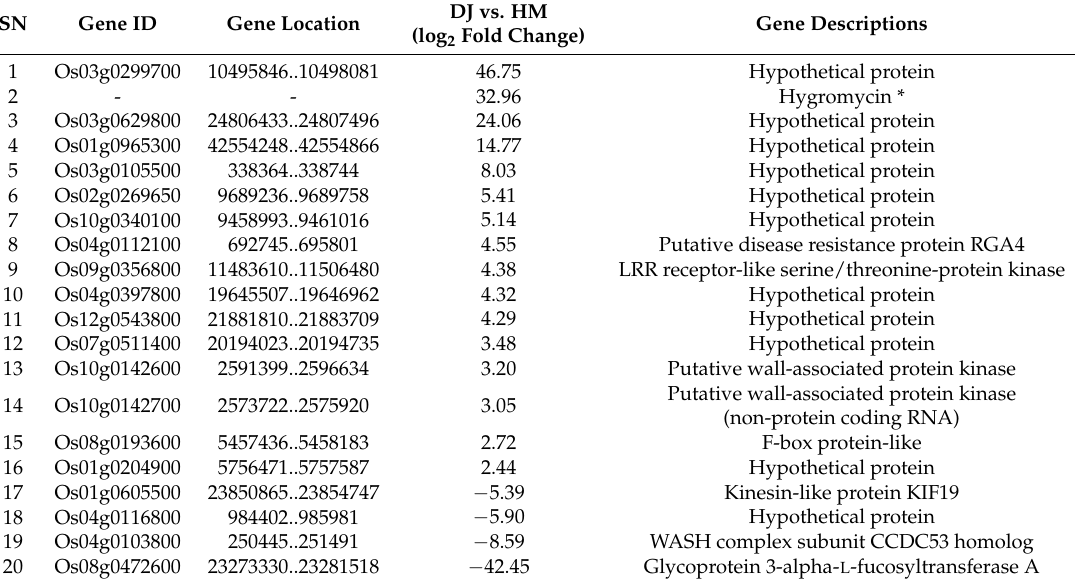
Table 2. Microarray genes significantly ( − log 2 fold change >2 and p < 0.05) up- and down-regulated in the Osfuct mutant (HM) compared with